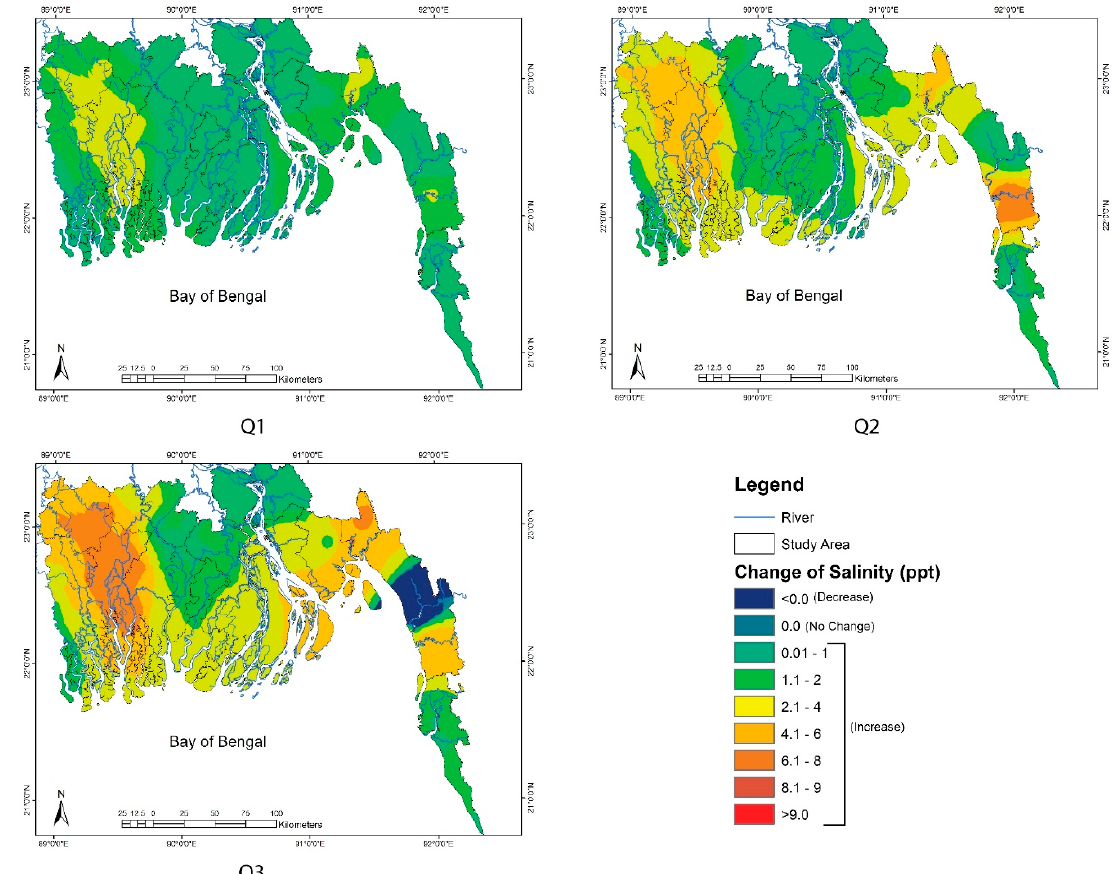
Figure 9. Change of salinity magnitude for reduced discharge (Q 1 , Q 2 , and Q 3 )